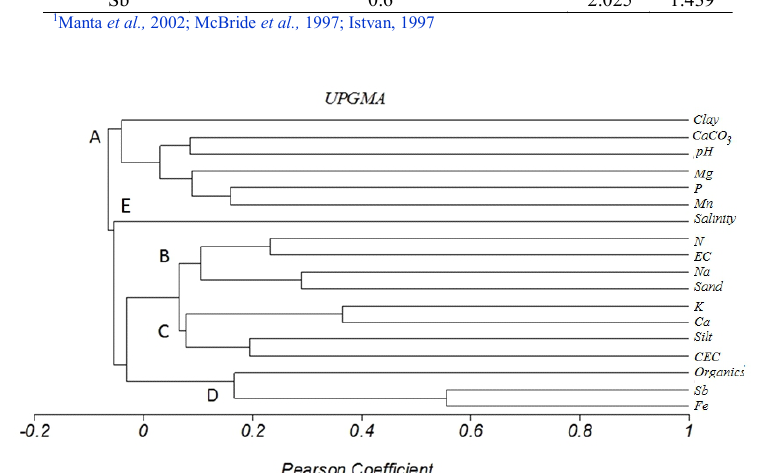
Fig. 2: Cluster analysis amongst heavy metals and physico-chemical parameters in Hamedan